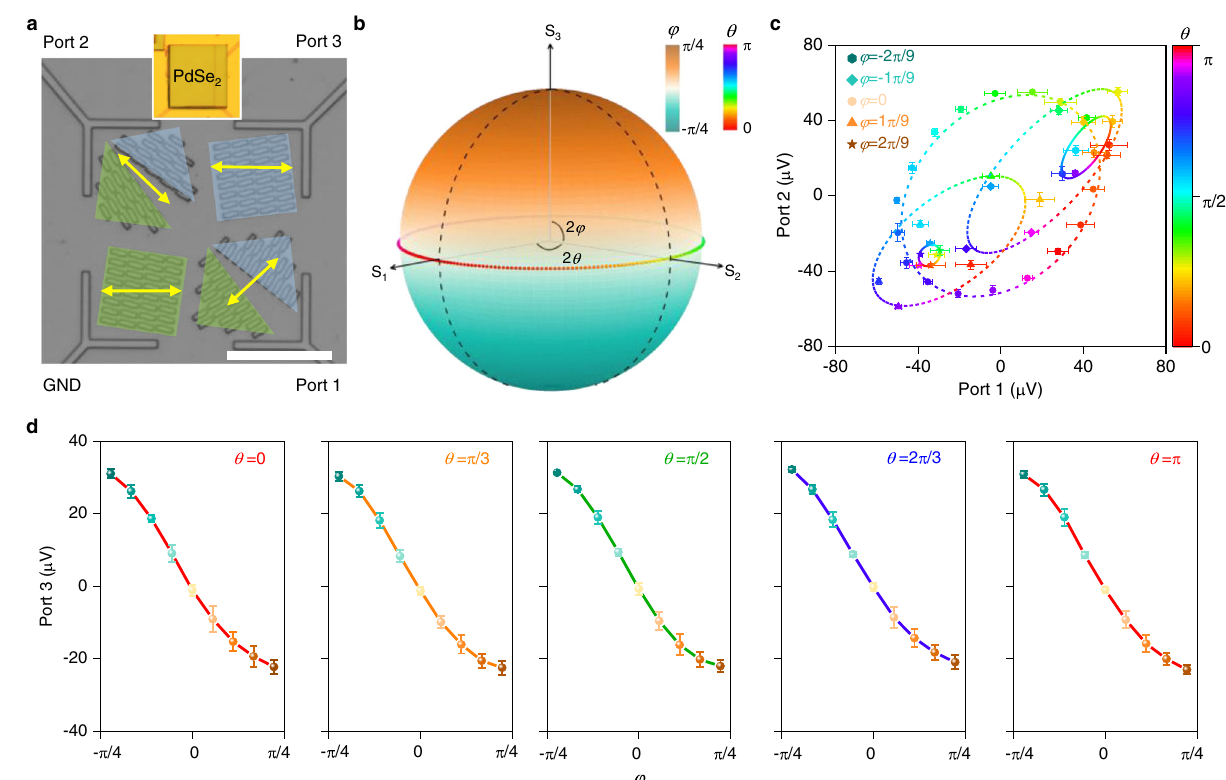
Fig. 4 | Full-Stokes polarization detection. a Optical image of metamaterials and electrodes of the three-ports device for full-Stokes polarization detection. The GND port is used as the ground terminal for other three port outputs. The yellow arrows indicatethe equivalentorientationof metamaterialsineachpart,and the greenand blue colors indicate LH and RH chiral metamaterials, respectively. Scale bar: 25 µ m. Inset is the optical image of the device. b Schematic illustration of the full-Stokes information in a Poincare ́ sphere. S 1 and S 2 are the linear parameters that